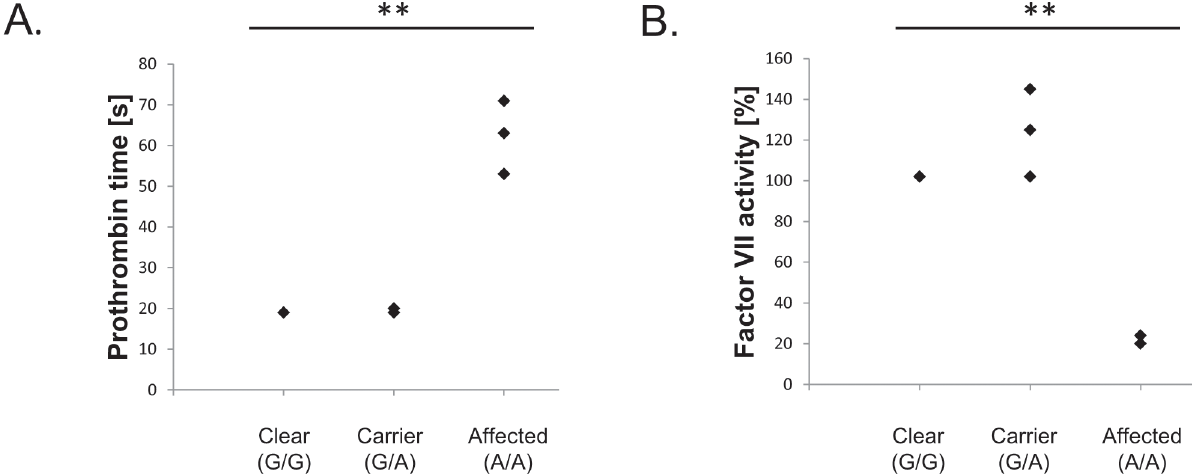
Fig 1. Coagulation factor VII deficiency in the Welsh Springer Spaniel. (A) Prolonged prothrombin times (t(2) = 8.21, p = 0.007) but normal partial thromboplastin times (data not shown); and (B) low plasma factor VII activity (t(3) = 9.17, p = 0.001) indicate functional factor VII deficiency and increased bleeding tendency in Welsh Springer Spaniels homozygous for the F7 gene c.407G > A missense variant. ( ** P <